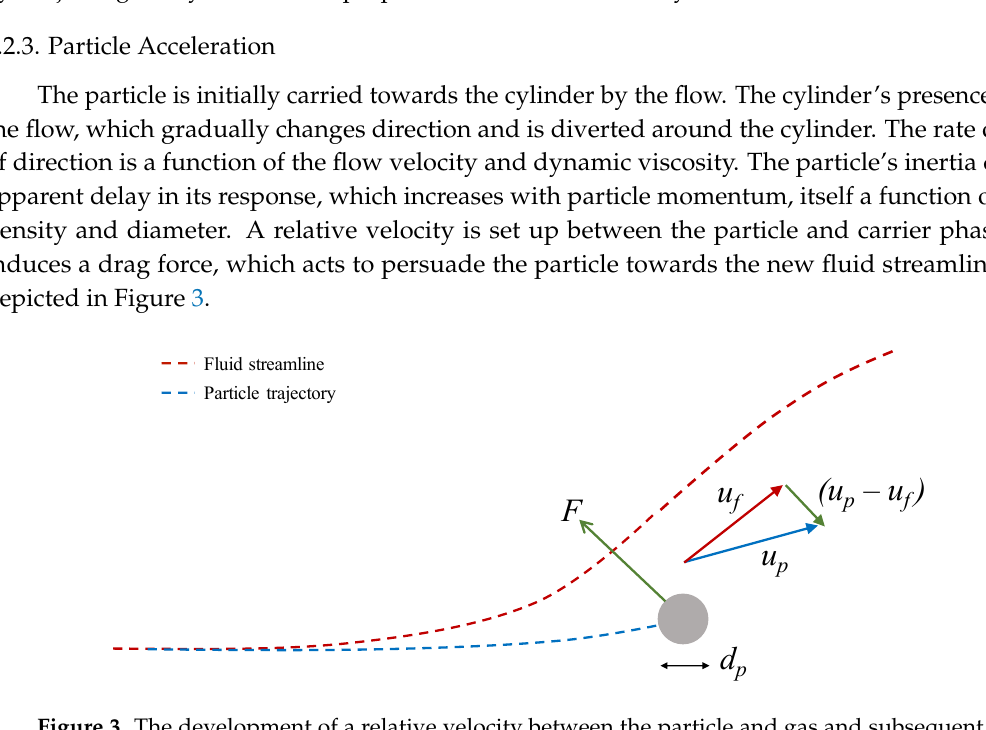
Figure 3. The development of a relative velocity between the particle and gas and subsequent drag force as a result of a perturbation in the fluid